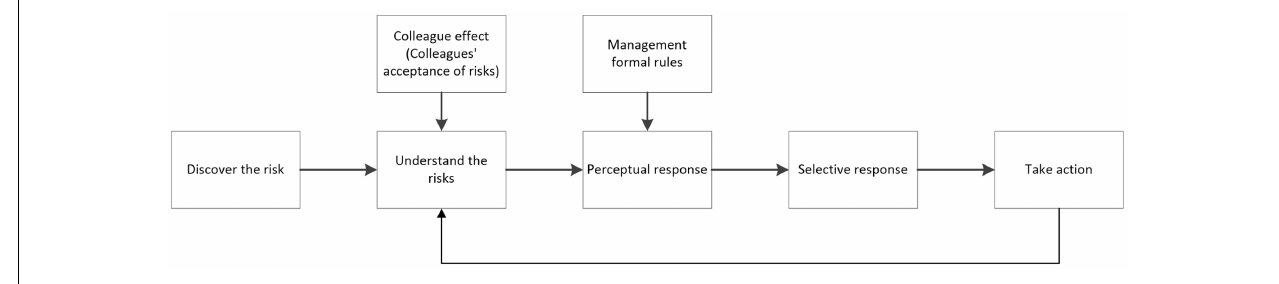
FIGURE 1 | Worker interaction